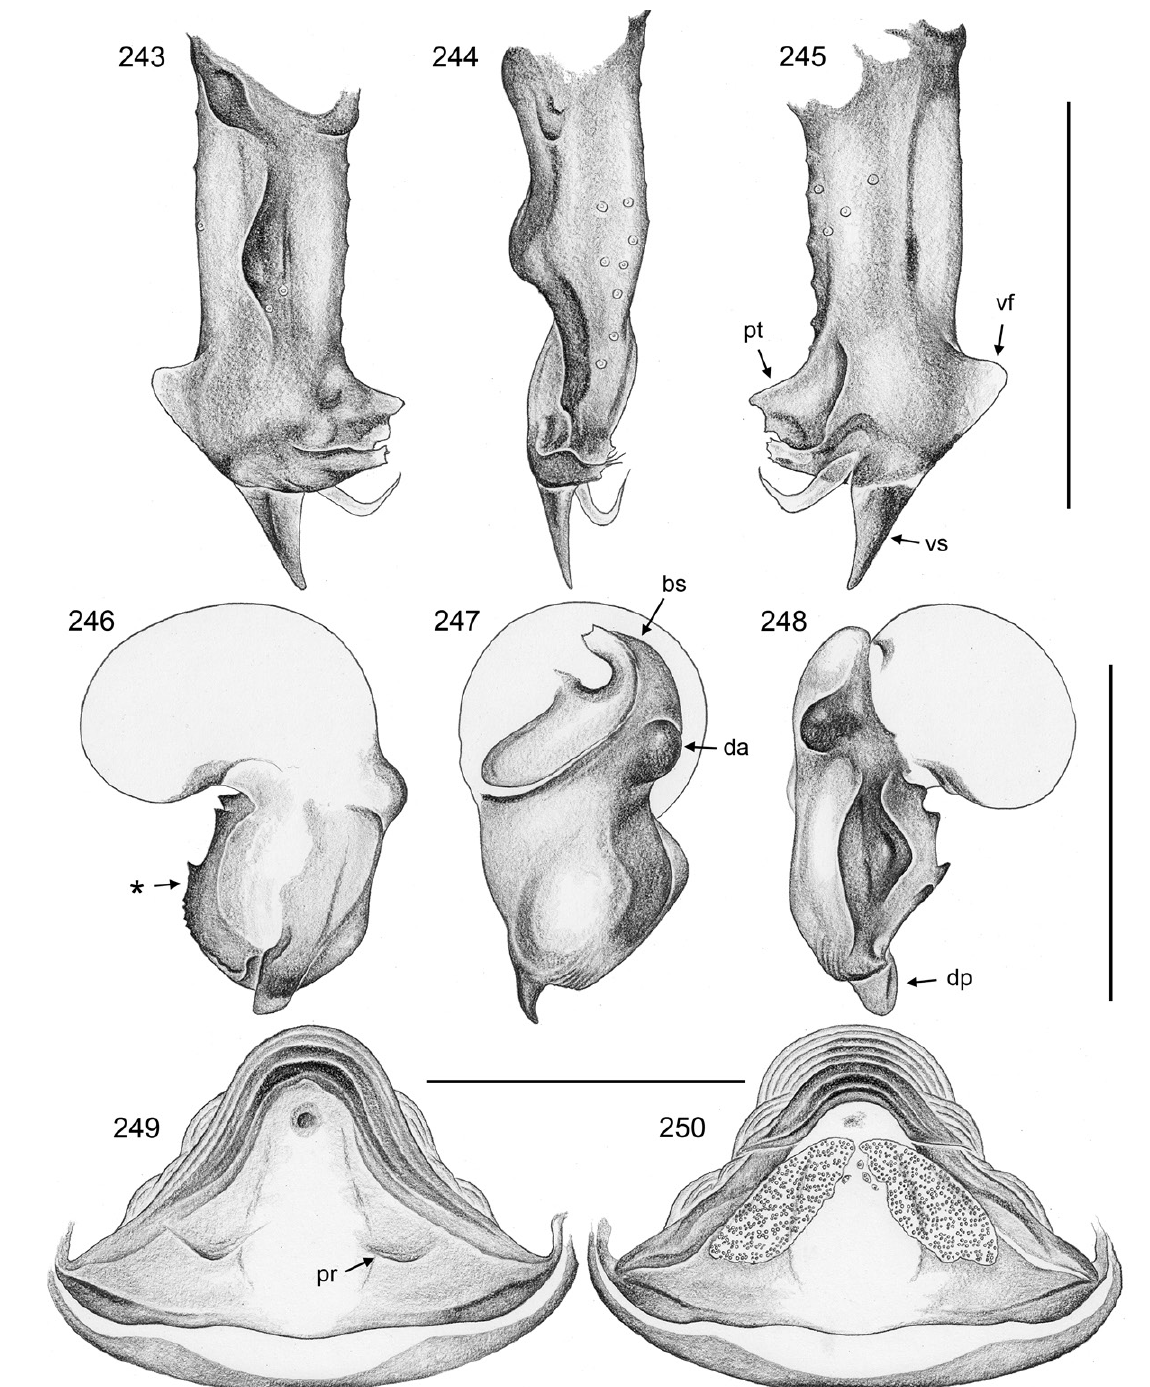
Figs 243–250. Maghreba nkob gen. et sp. nov.; male and female from Morocco, E of Nkob (ZFMK Ar 22374). 243–245 . Left procursus, prolateral, dorsal, and retrolateral views. 246–248 . Left genital bulb, prolateral, dorsal, and retrolateral views; asterisk: one or two additional small teeth present in males from N of Alnif and N of Errachidia. 249–250 . Cleared female genitalia, ventral and dorsal views. Abbreviations: bs = basal sclerite; da = dorsal apophysis; dp = dorsal process; pr = epigynal process; pt = procursus tip; vf = ventral flap; vs = ventral sclerite. Scale bars = 0.5